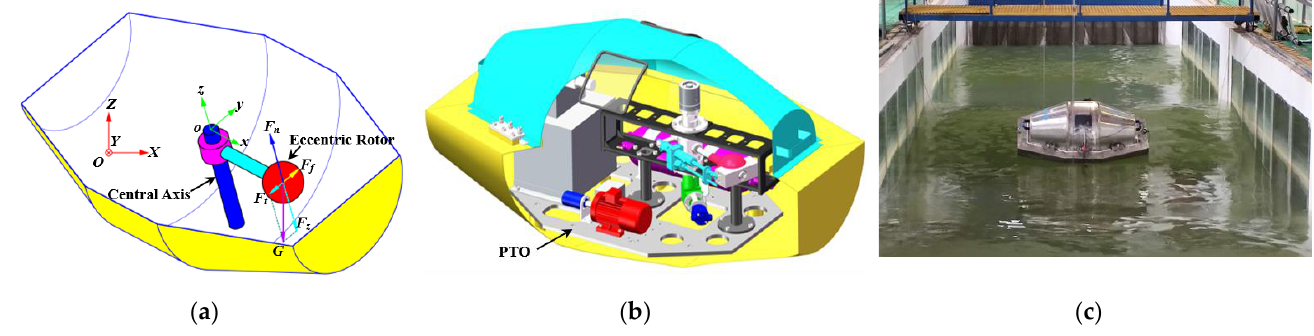
Figure 1. Mechanical structure of the ERWEC. ( a ) The energy conversion principle of the ERWEC; ( b ) 3D schematic diagram of a wave energy device designed according to the principle of the ERWEC; ( c ) the physical model of the ERWEC and the experimental process.